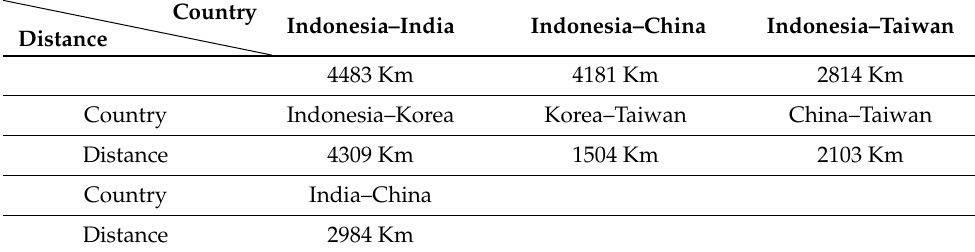
Table 6. Distance between